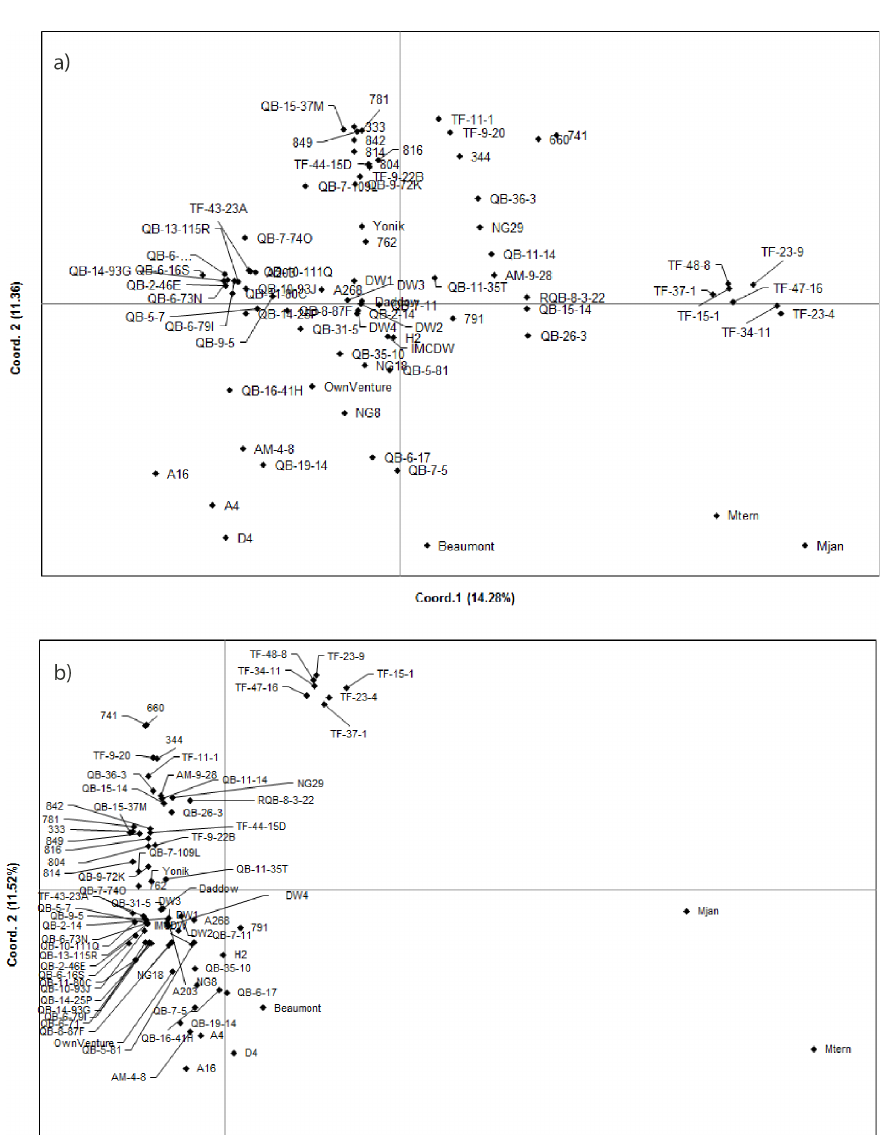
Fig 5. Principal coordinate analysis (PCoA) to explain the genetic diversity across macadamia accessions. a) PCoA based on silicoDArT markers, and b) PCoA based on SNP markers.